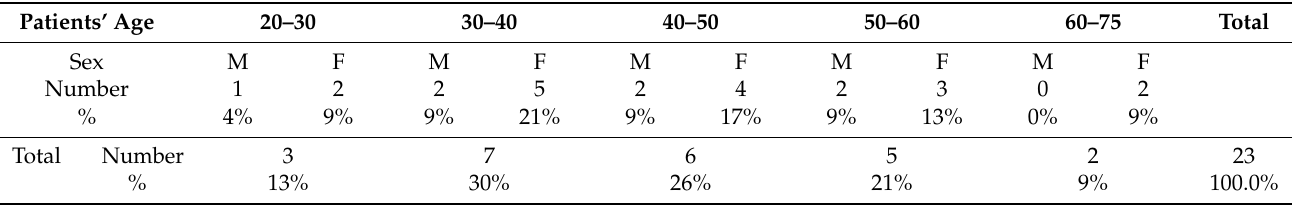
Table 1. Distribution of patients by sex and age.